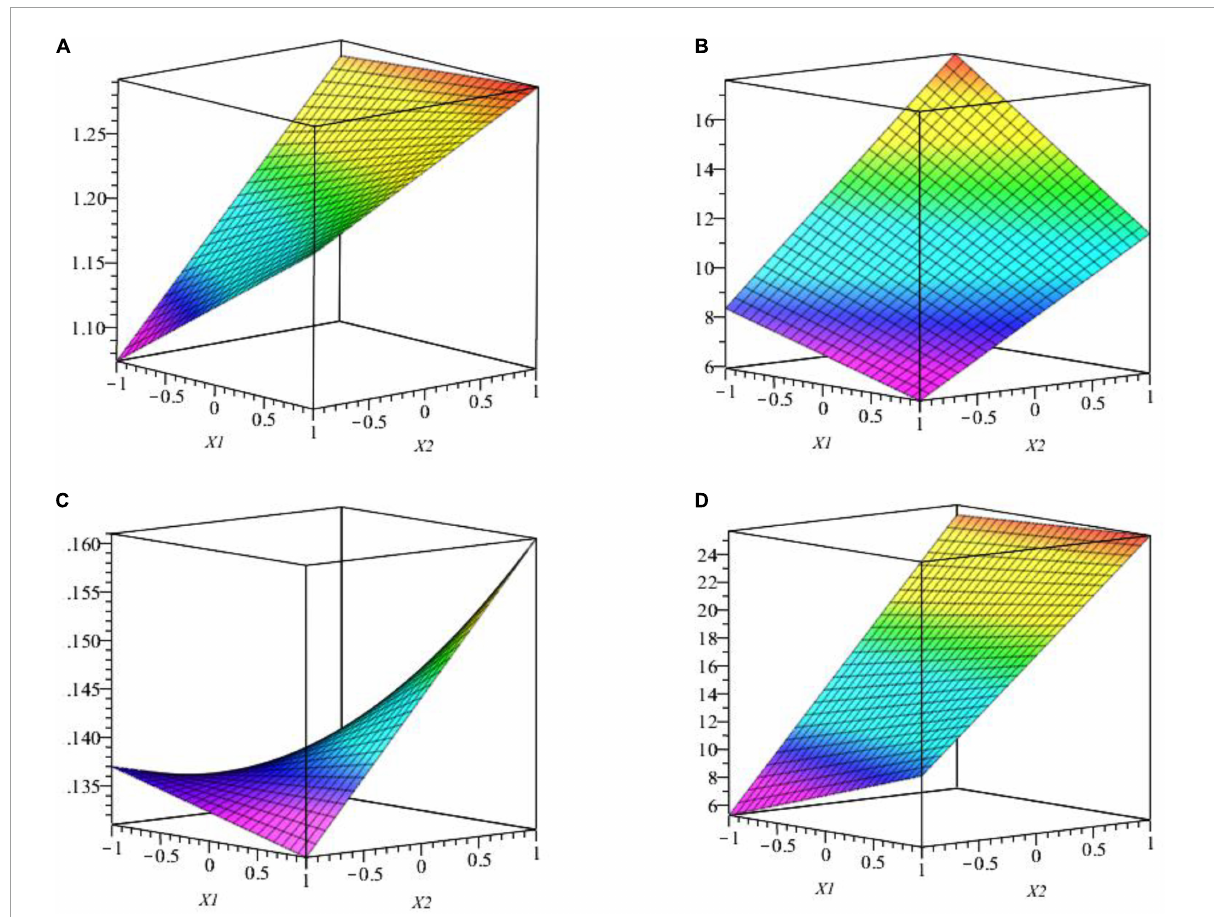
FIGURE6 (A) The effect of studied factors (X 1 and X 2 ) and their interaction on pH surface response by WJEF26 strain. (B) The effect of studied factors (X 1 and X 2 ) and their interaction on the response surface of P[C] by WJEF26 strain. (C) Effect of studied factors (X 1 and X 2 ) and their interaction on response surface of pH with WJEF63 strain. (D) Effect of studied factors (X 1 and X 2 ) and their interaction on response surface of P[C] with WJEF63